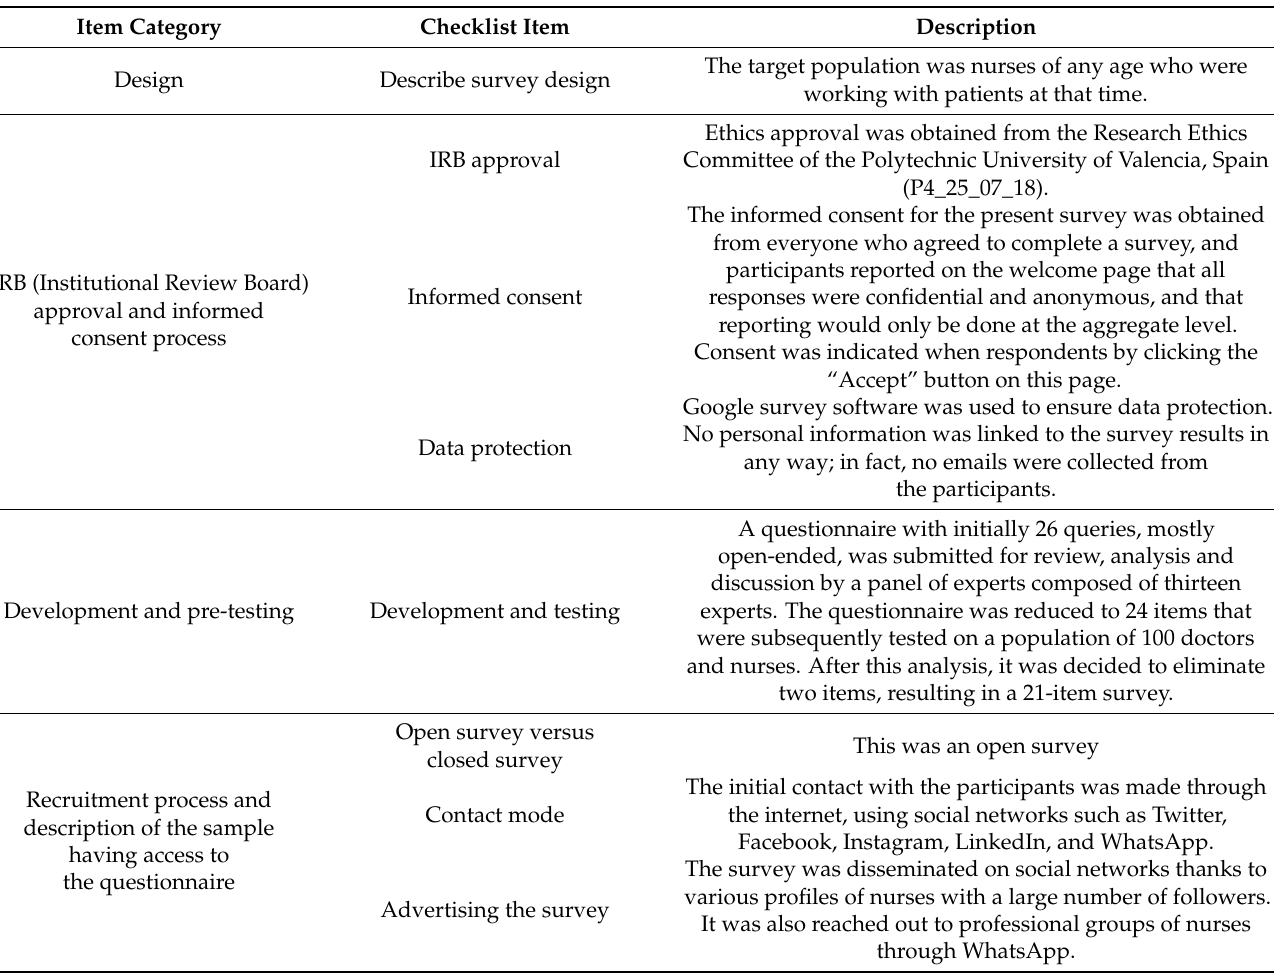
Table A1. Checklist for Reporting Results of Internet E-Surveys (CHERRIES)